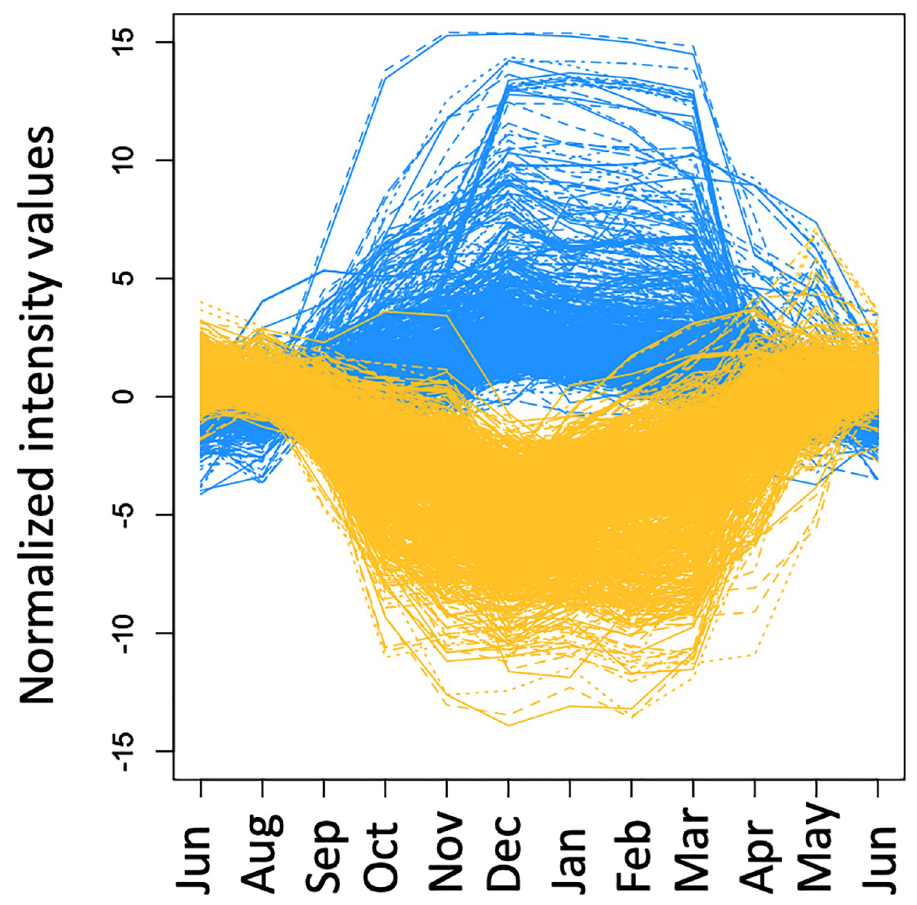
Fig 2. Annual expression pattern of the top-scoring targets of principal component 1. Annual expression patterns of the targets with the top 1,000 positive and negative scores for principal component 1 (blue and orange, respectively). Each line represents the average normalized intensity value of an individual